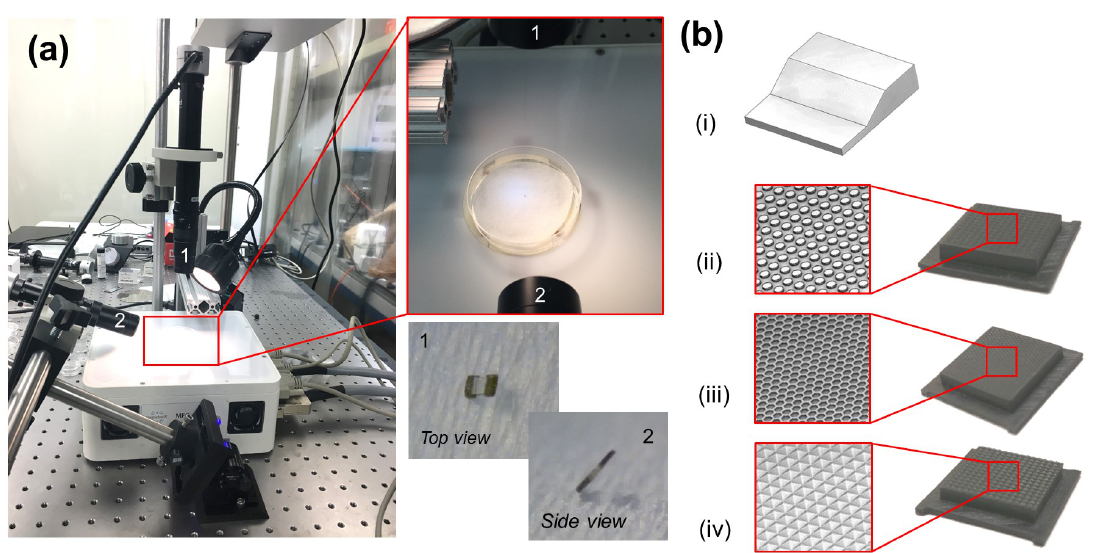
Figure 6. ( a ) The MFG-100 system with the top camera (1) and side camera (2). The paper surface inside a Petri dish at the center of the workspace. Top and side views of a µ TUM as seen through the cameras. ( b ) Qualitative diagram of the various terrain geometries designed and fabricated: (i) inclined plane, (ii) cylindrical bumps, (iii) honeycomb and (iv)